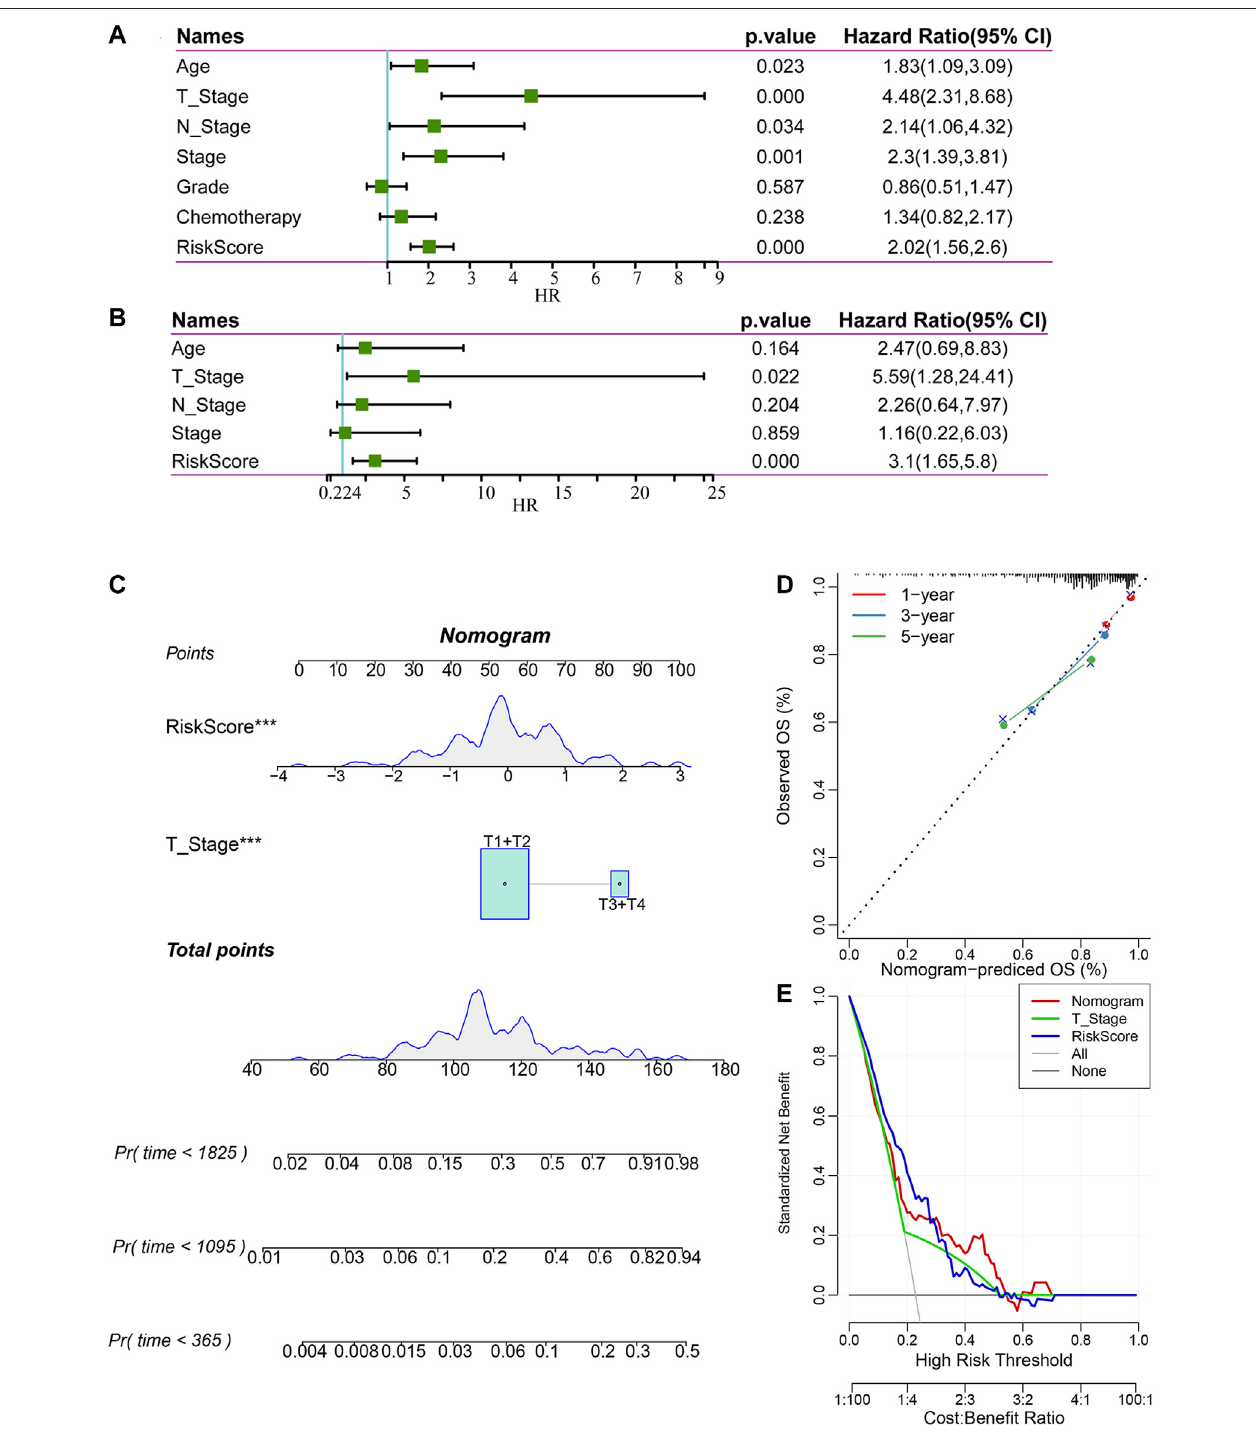
FIGURE 9 | Construction and evaluation of a nomogram. (A) Univariate Cox regression analysis of clinical characteristics and risk score. (B) Multivariate Cox analysisofclinicalcharacteristicsandriskscore. (C) Anomogramforpredictingthe1year,3yearsand5 yearssurvivalratesofCCpatientswasestablished. (D) 1year,3 years, and 5 years survival rate calibration curves of the line chart. (E) The DCA of the nomogram.